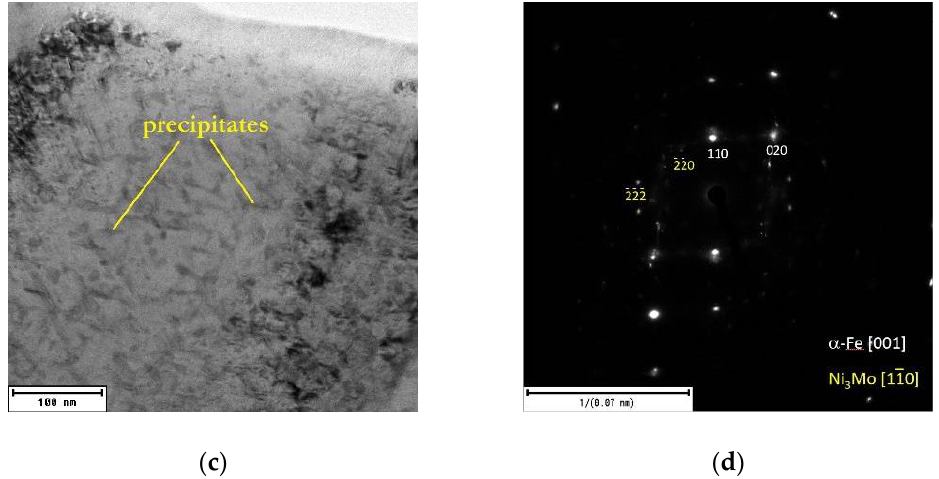
Figure 8. TEM micrographs and SAED patterns of the 1.2709 maraging steel after heating at 500 °C: ( a , b ) as-printed; ( c , d ) as-heat-treated.